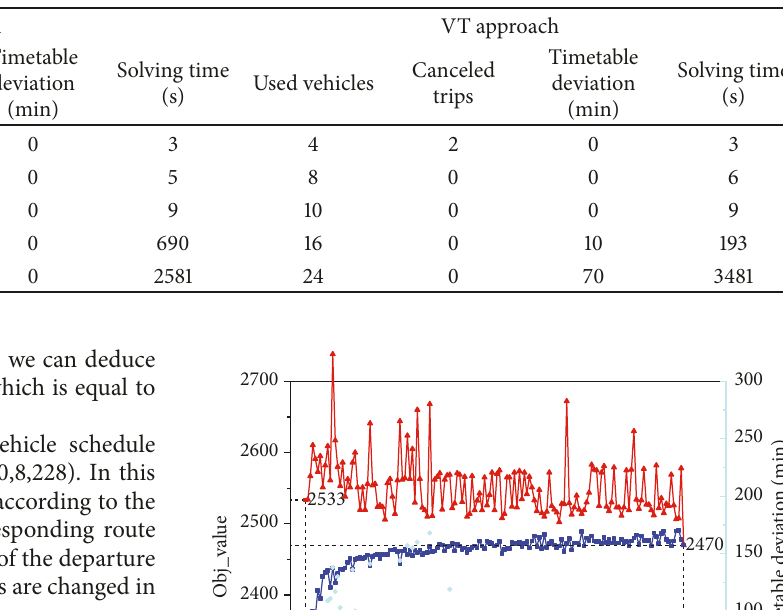
Table 4: The solutions for FT approach and VT approach.